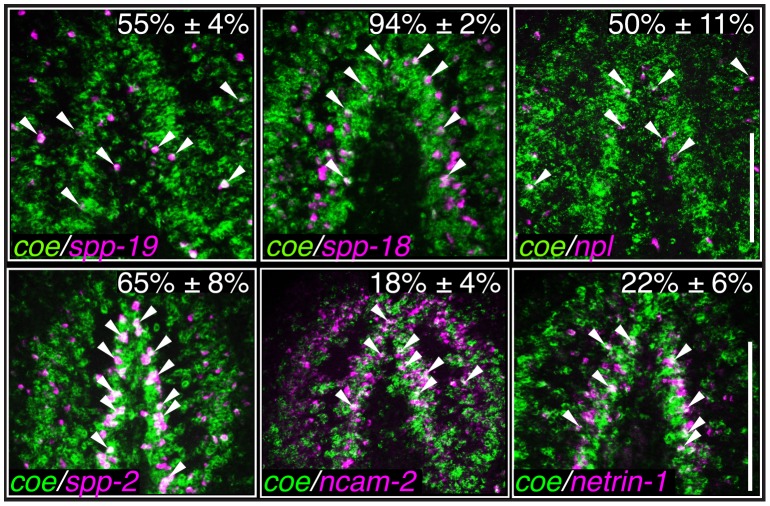
Identification of genes expressed coe+ neurons.Fluorescent in situ hybridization to coe and either spp-19, spp18, npl, spp-2, ncam-2, or netrin-1. Percentages indicate the proportion ± s.d. of cells that were also coe+ (N = 110 spp-19+, 319 spp-18+, 173 npl+, 202 spp-2, 236 ncam-2, and 141 netrin-1 cells counted from 2–3 animals per group). Arrowheads mark double-labeled cells. Anterior is up in all panels. Scale bars = 100 µm.